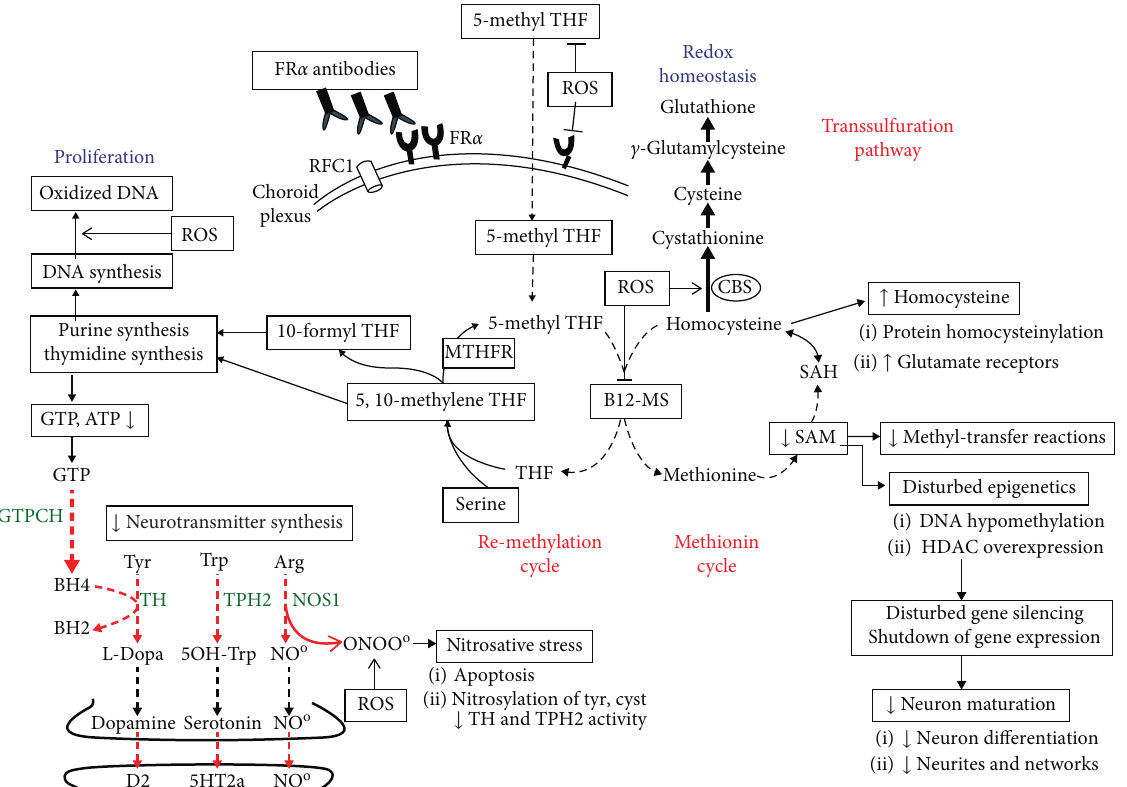
Figure 1: Pathophysiology of autism based on our findings showing the impact of reactive oxygen species (ROS) at different levels of intermediary metabolism and the consequences of brain 5-methyltetrahydrofolate (5-methyl THF) deficiency due to FR α auto- immunity. ROS inhibits B12-methionine synthase (B12-MS) activity and stimulates cystathionine beta synthase (CBS) activity, shifting the homocysteine accumulation from the methionine cycle into the transsulfuration pathway with increased production of the natural antioxidant glutathione. Superoxide anions also react with NO at the level of NO-synthase (NOS1) to form peroxynitrite instead of NO, which predisposes to apoptosis and nitrosylation of tyrosine and cysteine. Nitrosative stress affects activity of tryptophan (TPH2) and tyrosine hydroxylases (TH), the rate-limiting enzymes for serotonin, and dopamine synthesis. In addition, ROS catabolize 5-methyl-THF and impair folate uptake and transcellular transport across the choroid plexus and placental barriers due to interaction with FR α and RFC1 folate transporters. FR α autoantibodies also impair folate transport to the fetus and brain. The resulting brain folate deficiency predisposes to reduce SAM production and SAM-dependent methyl-transfer reactions and reduces purine and thymidine synthesis with diminished GTP and BH4 production. The diminished BH4 availability as the shared cofactor of the enzymes TH, TPH2, and NOS1 will therefore reduce their enzyme activity. Reduction of the activated methyl group donor SAM downregulates DNA methylation and affects posttranslational modifications of histones (methylation and trimethylation of histones), thereby impeding the homeostatic balance between gene transcription and silencing. In addition, folate deficiency is accompanied by overexpression of histone deacetylases, which further leads to abnormal gene silencing. The shutdown in expression of specific sets of genes will affect neuronal growth, pruning, and differentiation. Abbreviations: GTPCH: GTP-cyclohydrolase I; Arg: arginine; Cyst: cysteine; Tyr: tyrosine; Trp: tryptophan; MTHFR: methylenetetrahydrofolate reductase; RFC1: reduced folate carrier-1 (reproduced with permission from